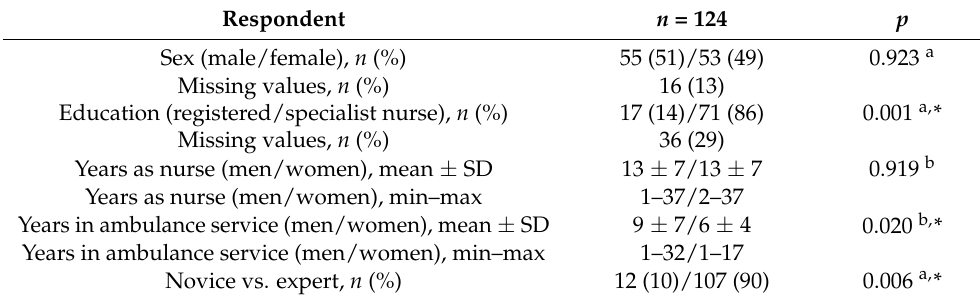
Table 1. Absolute and relative frequencies by sex, education (registered nurse vs. specialist nurse), years as a nurse, years in ambulance service, and novice (<5 years) vs. expert ( ≥ 5 years). Respondent n = 124